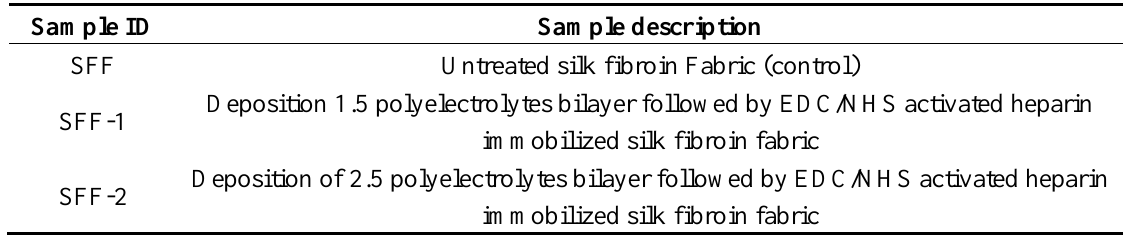
Table 1. Sample notation and description.